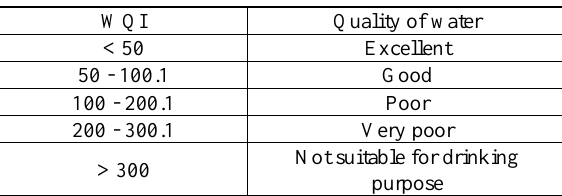
Figure 2. Box plot for pre-monsoon